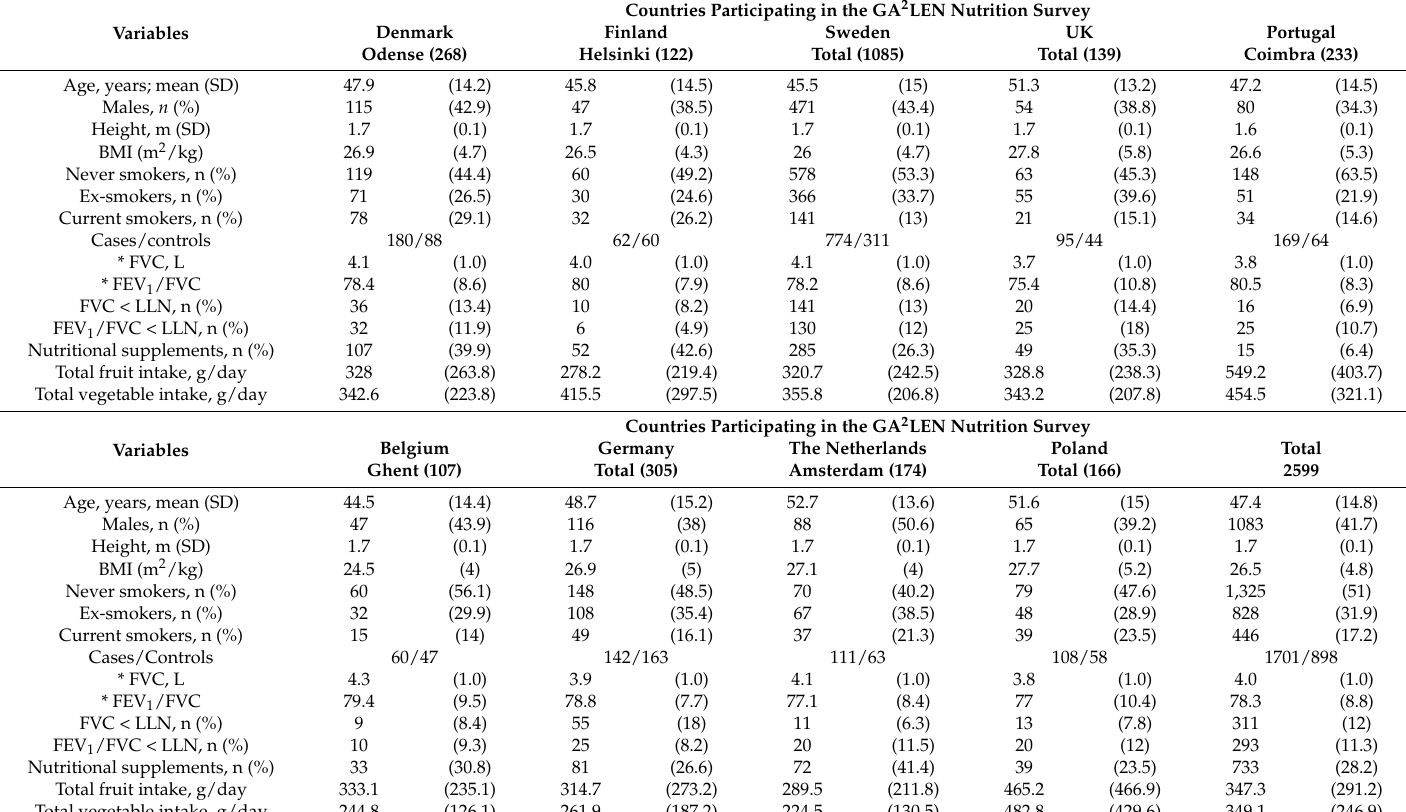
Table 1. General characteristics of the study population ( n = 2599) #